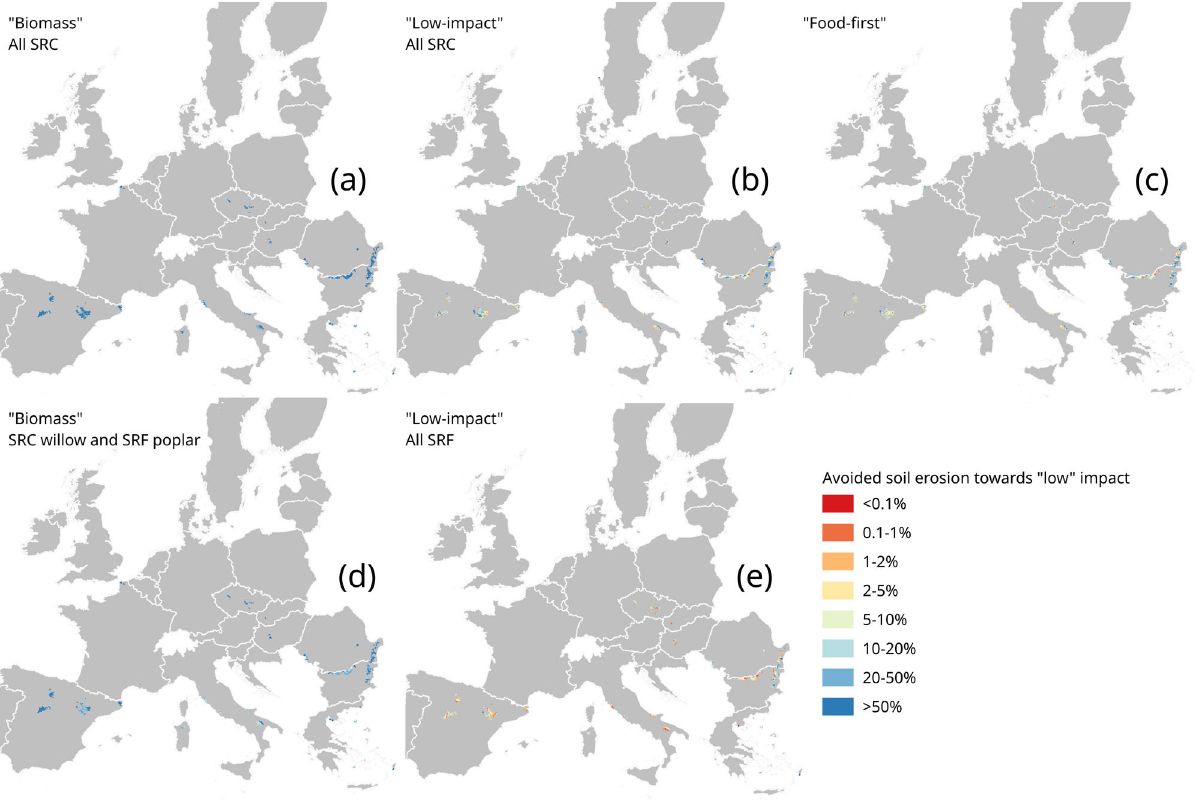
Fig. 6 Avoided soil erosion due to implementation of windbreaks. Degree to which establishment of windbreaks contribute towards reducing soil loss by water erosion down to a low-impact level, for the different deployment scenarios ( a – e ), and different windbreak options for the Biomass ( a , d ) and Low- impact ( b , e )